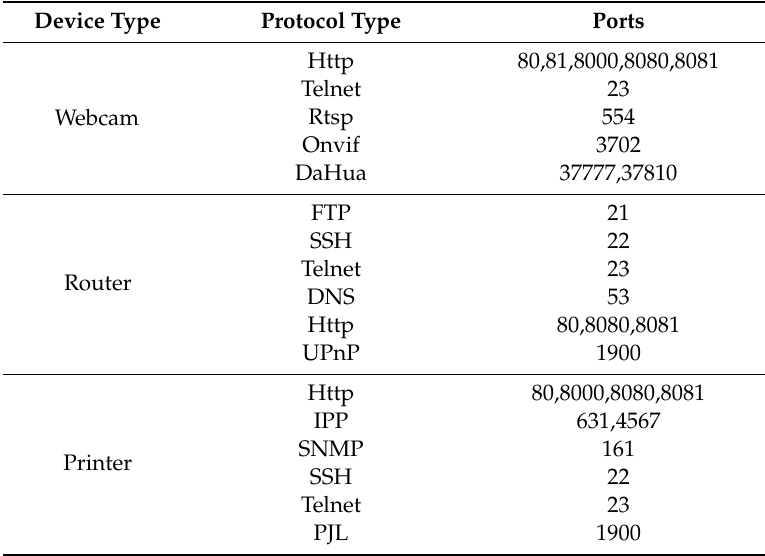
Table 1. Predominant IoT devices and their service protocols and ports.